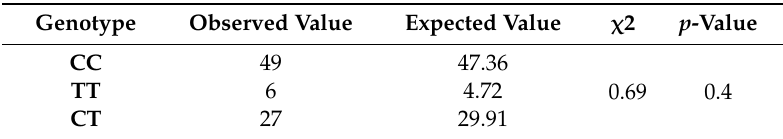
Table 3. Hardy–Weinberg equilibrium (HWE) results for the FokI polymorphism and its respective genotypes in the control group.